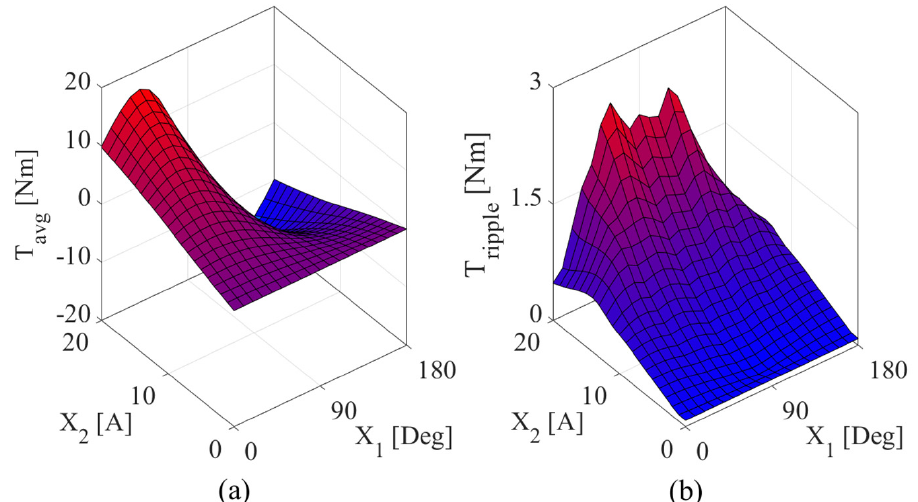
Figure 10. FEA results for torque performance of the PMASynRM: ( a ) Average Torque, and ( b ) Torque Ripple.